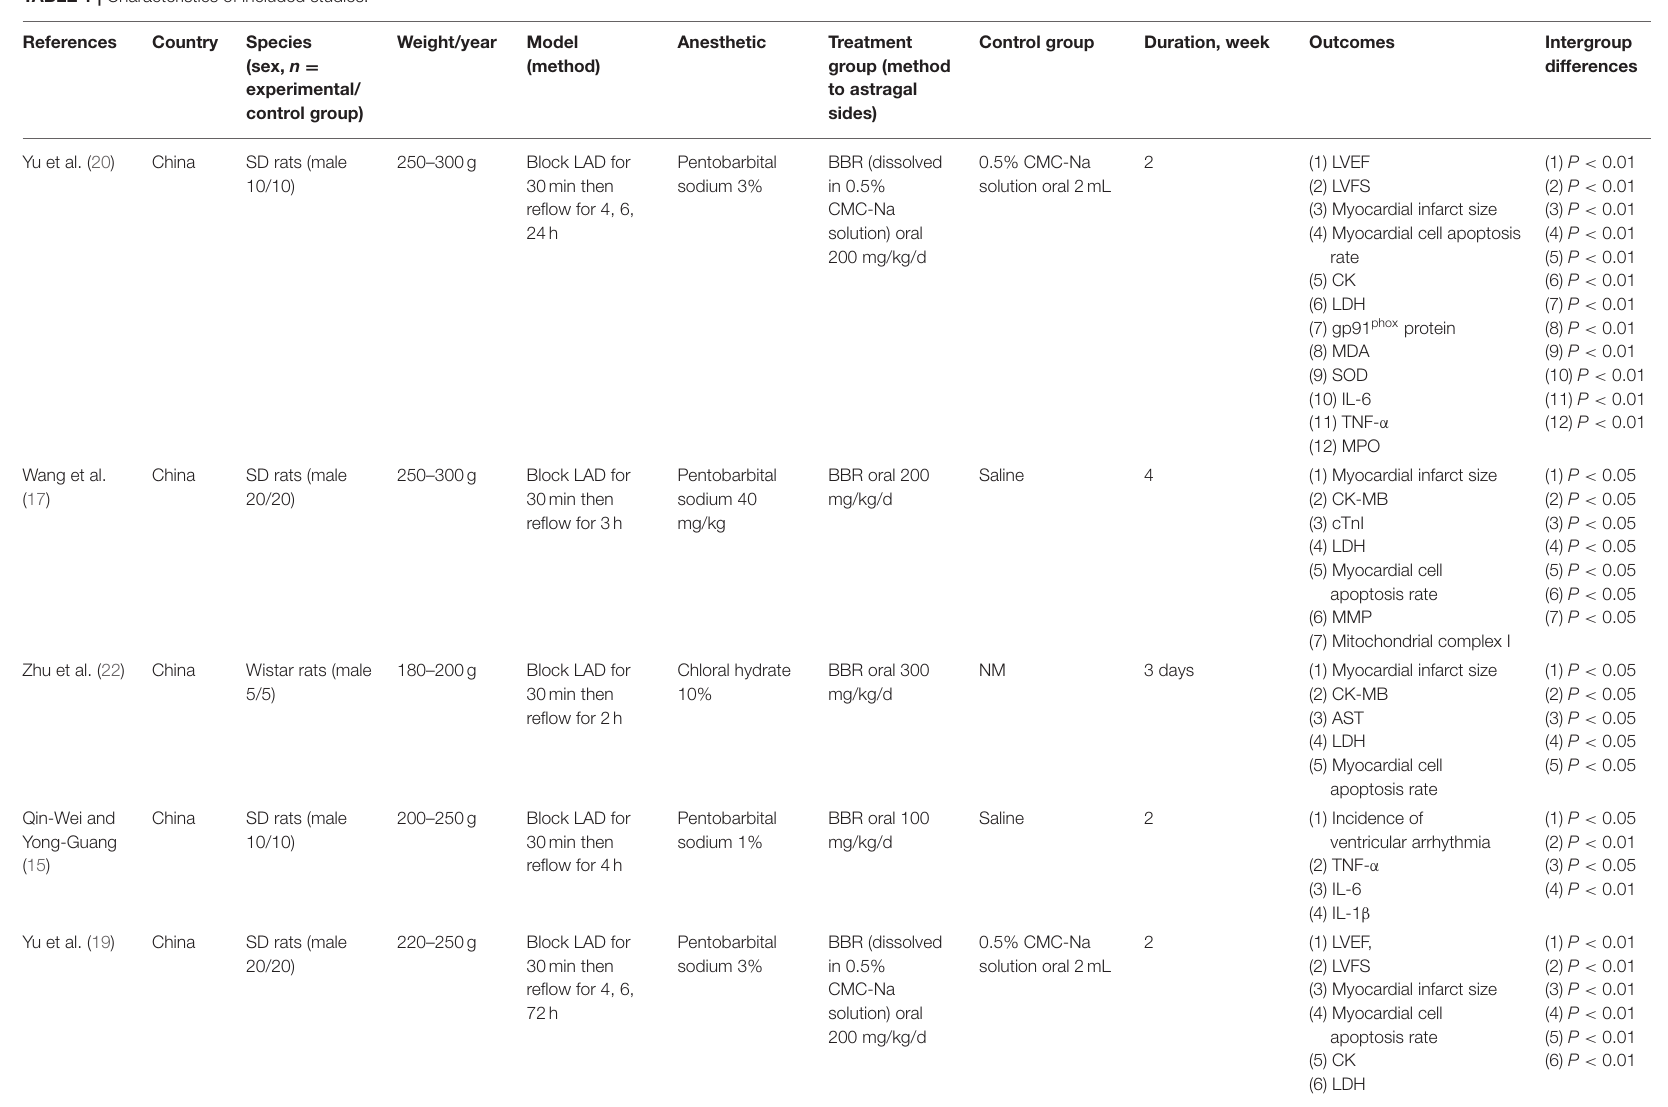
TABLE 1 | Characteristics of included